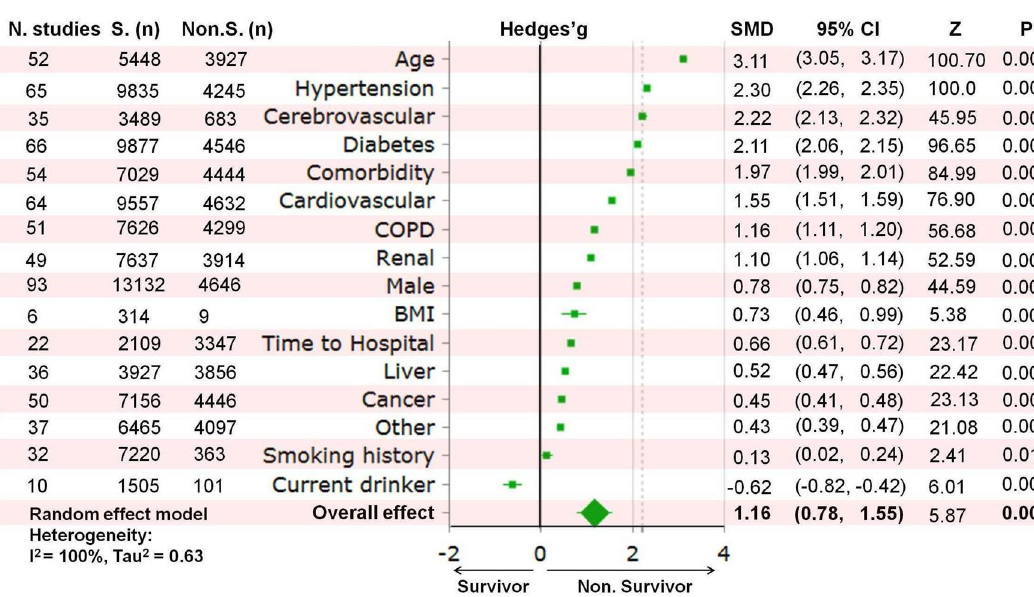
Figure 4. Forest plot of pre-existing health conditions in survivors and non-survivors of COVID-19. The Standardized Mean Difference (SMD) and the 95% confidence intervals (CIs) were used to define the prevalence of various risk factors and complications for survivors and non-survivors of COVID-19. Time to hospital, time from symptoms appearance to hospitalization; Cerebrovascular, cerebrovascular disease; Cardiovascular, cardiovascular disease; Renal, renal disease; Liver, liver disease; BMI, body mass index; COPD, chronic obstructive pulmonary disease; S, survivors; n, population